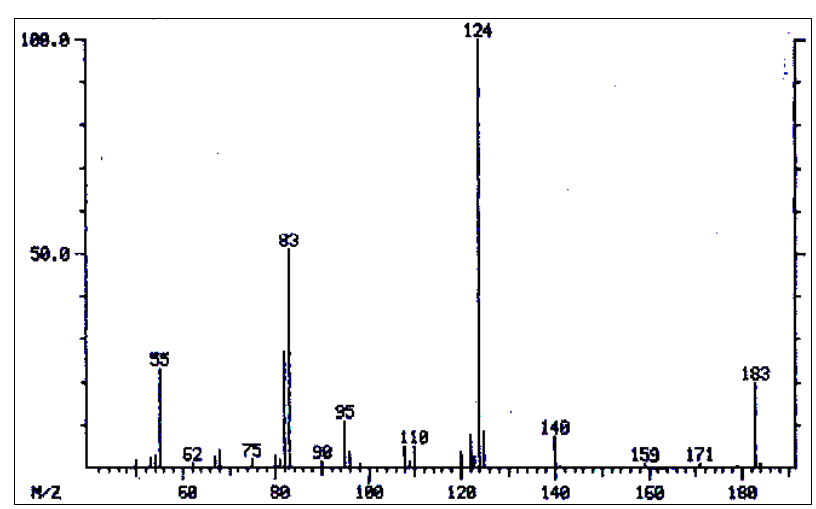
Figure 4. Mass spectrum of 9-acetyltrachelanthamidine.